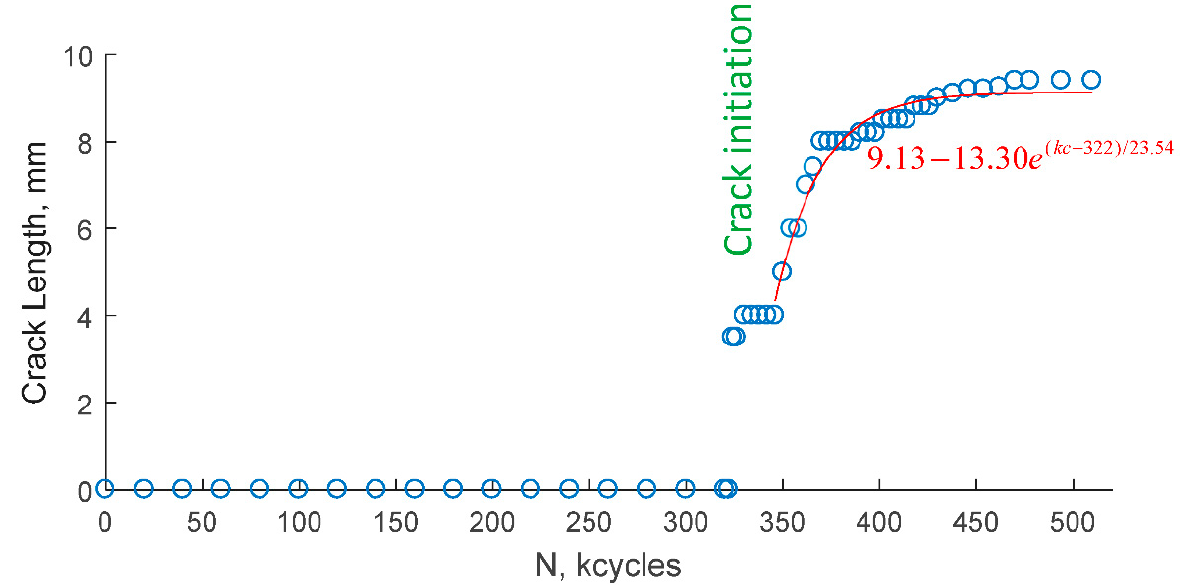
Figure 12. Fatigue crack growth during the experiment.